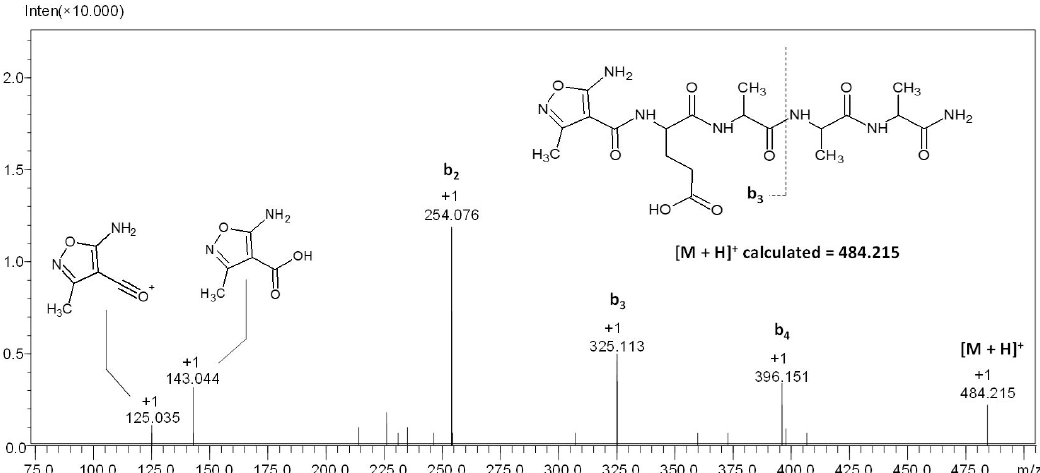
Figure 5. ESI-MS/MS spectrum of compound 2 . Parent ion m / z 484.215, collision energy 20–40